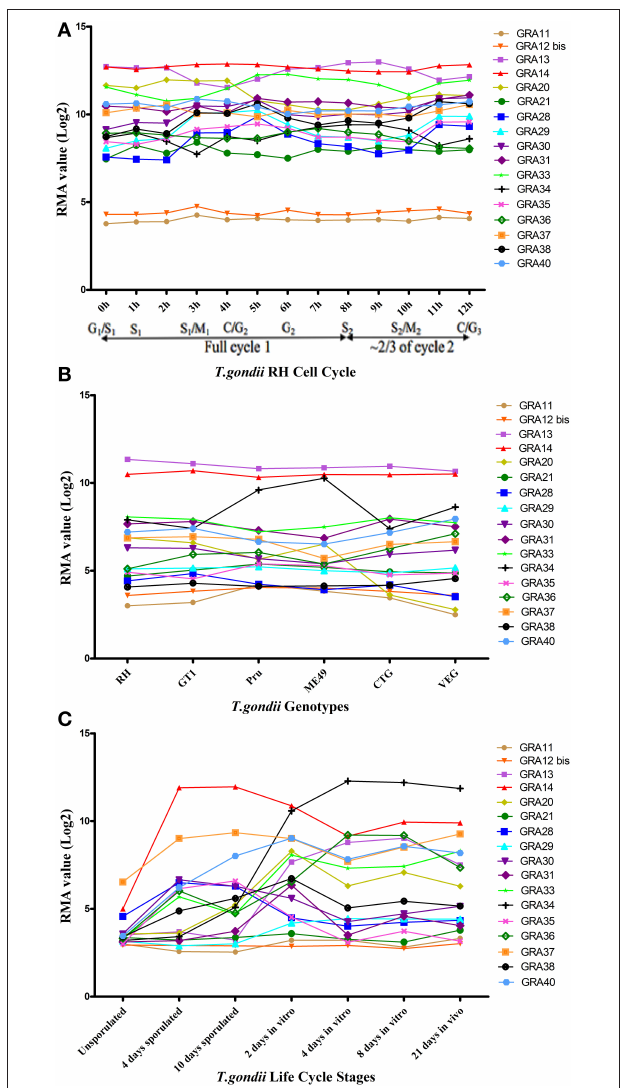
FIGURE 4 | The trend charts of the distinct expression profiles of Toxoplasma gondii GRAs . (A) Time-series expression profile of 17 GRA genes of T. gondii RH strain by cell cycle phases of the parasite as described by Behnke et al. (2010). (B) Transcriptomic expression profiles of 17 GRA genes in Type I (RH and GT1), Type II (Pru and ME49), and Type III (CTG and VEG) strains. (C) Transcriptomic profiles of 17 GRA genes related to the parasite life cycle stages (oocyst, tachyzoite and bradyzoite). Expression profile of 17 GRA genes of the oocysts recovered from cat feces, at 0 day (unsporulated), 4 days (4 day sporulated), and 10 days (10 day sporulated), tachyzoites grown for 2 days in HFF cells (2 day in vitro ), bradyzoites grown in HFF cells for 4 days and 8 days (4 day in vitro and 8 day in vitro ), and 21 days tissue cyst-containing bradyzoites harvested from infected mouse brains (21 day in vivo ). Each line represents the expression value of the corresponding gene. The data were obtained from ToxoDB (36 release) and the graph was generated using GraphPad Prism version